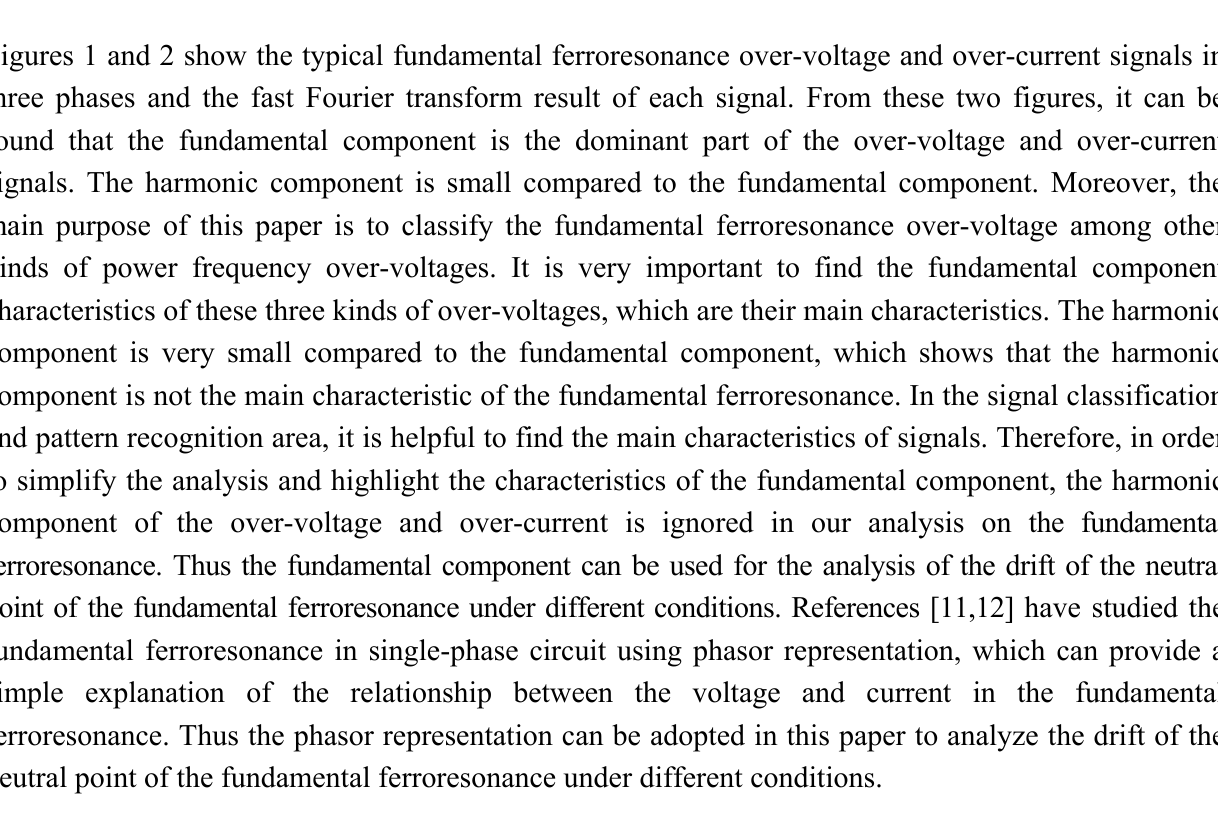
Figure 1. Simulated fundamental ferroresonance over-voltage signals and the Fourier transform